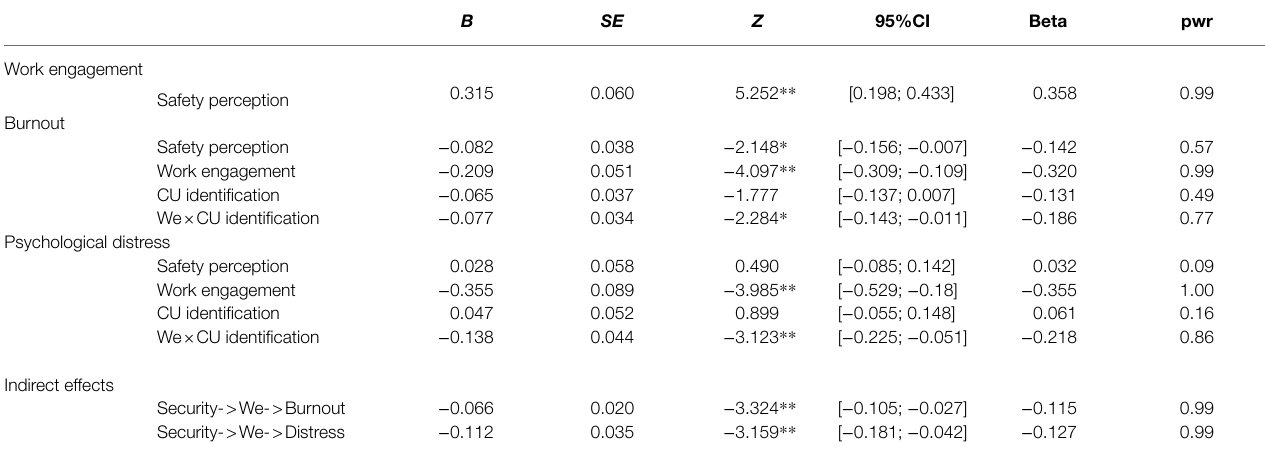
TABLE 2 | Estimates from the structural equation